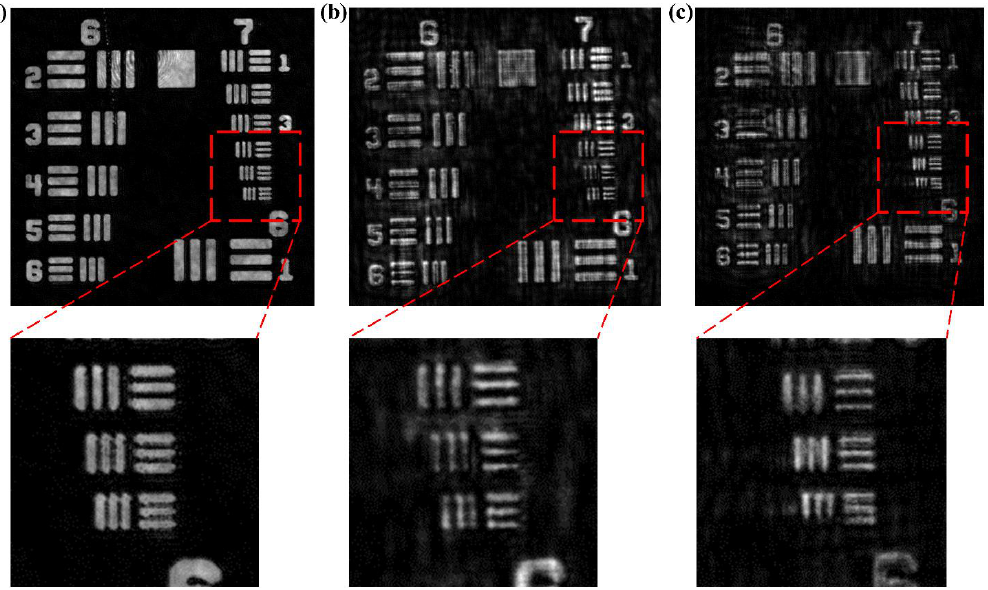
Figure 2. The reconstructed image of the USAF 1951 resolution plate. ( a ) At 0 mm. ( b ) At 6 mm. ( c ) At −6 mm.